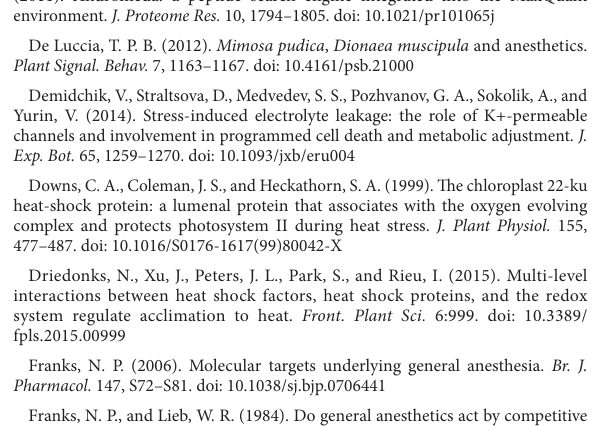
SUPPLEMENTARY TABLE S1 The complete list of significantly upregulated and downregulated differentially expressed genes (DEGs) in A. thaliana arranged from the highest to lowest log 2 fold change ( p < 0.05). SUPPLEMENTARY TABLE S2 The complete list of significantly enriched GO terms at p < 0.05 arranged from the lowest to highest adjusted p values ( p adj ) in A. thaliana . SUPPLEMENTARY TABLE S3 The complete list of significantly upregulated and downregulated differentially expressed proteins (DEPs) in A. thaliana arranged from the highest to lowest log 2 fold change ( p < 0.05). SUPPLEMENTARY VIDEO S1 Luminescence in whole A. thaliana rosette expressing the APOAEQUORIN gene with coelenterazine in response to diethyl ether application at time point 1 min. The plants were sprayed with coelenterazine and the signal is indicator of [Ca 2+ ] cyt . Photons were captured in photon-counting mode with a 5 min acquisition time. SUPPLEMENTARY VIDEO S2 Luminescence in whole A. thaliana rosette expressing the